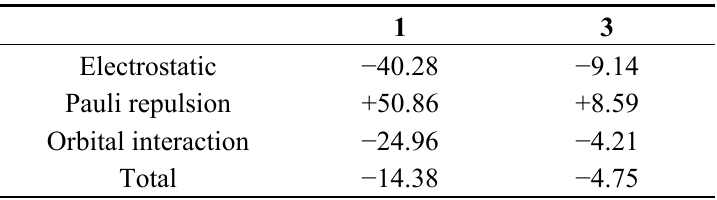
Table 2. ADF-EDA decomposed energy terms in